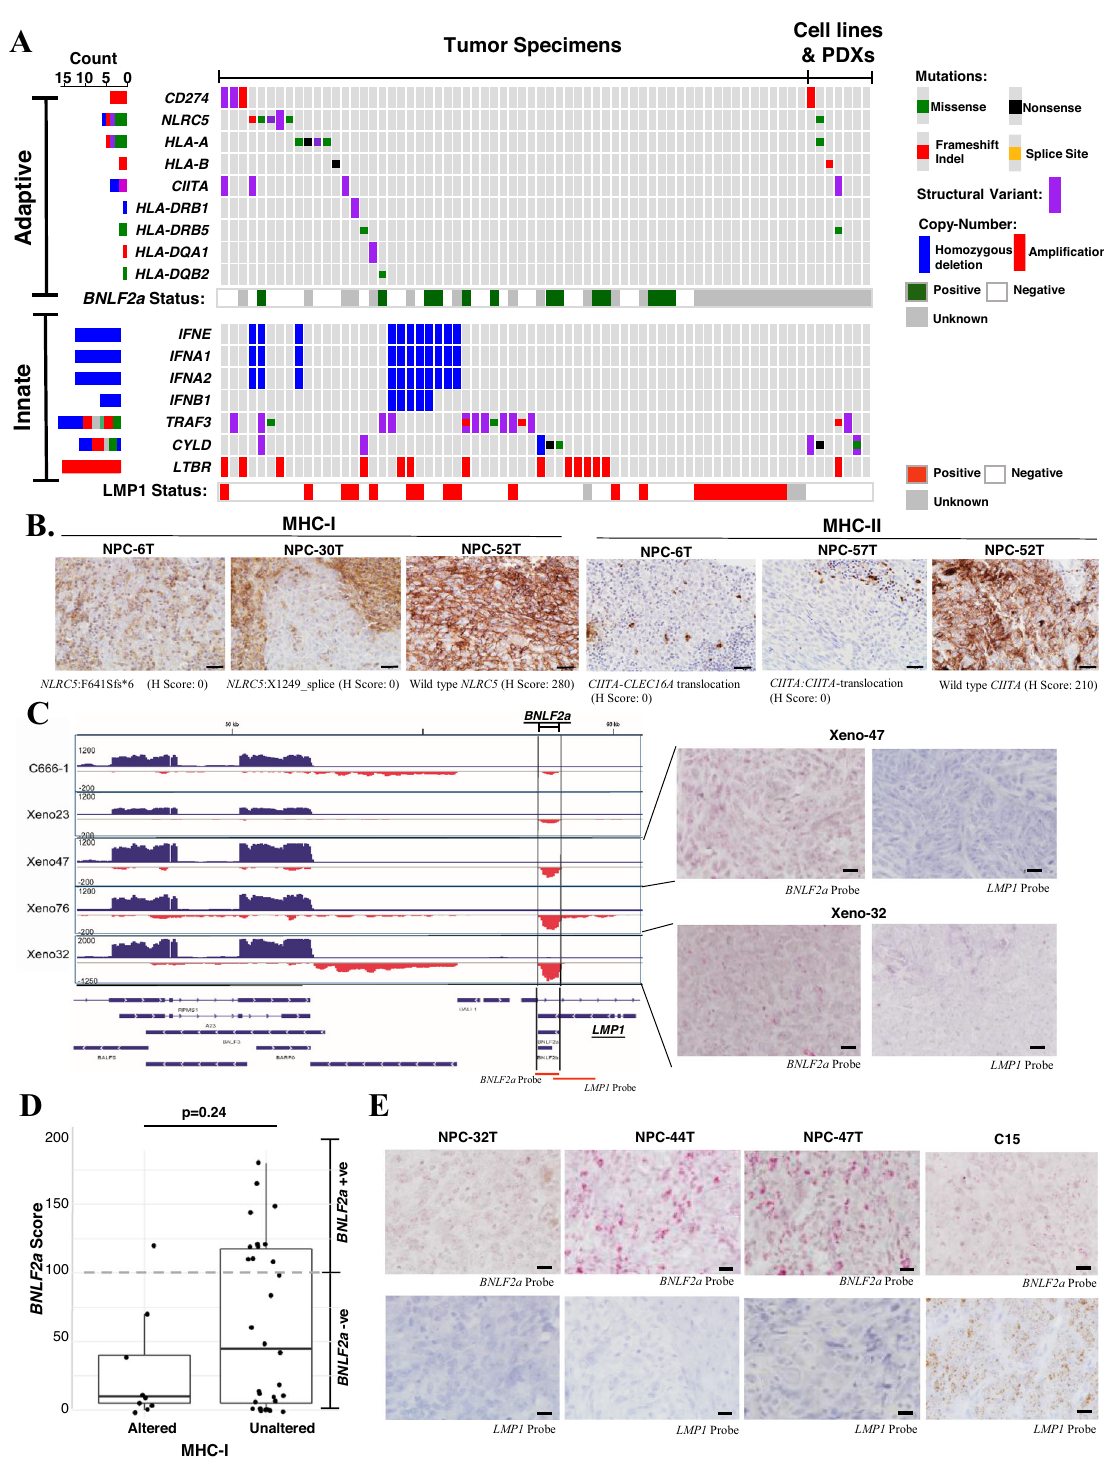
resistance to TGF- β -induced growth inhibition (Fig. 5E). To examine the effect of disrupting TGF- β /SMAD signaling on the outcome and stability of EBV infection in these immortalized NPE cells, the parental NP460 and TGFBR2 knockout NP460KO cells were infected with a green fl uorescent protein (GFP)-tagged recombinant EBV (Akata strain), and the EBV-positive cells were isolated using FACS and grown for 7 and 14 days as we described previously 31 . This experiment demonstrated that the ef fi ciency of persistent EBV infection was signi fi cantly increased in NPE cells